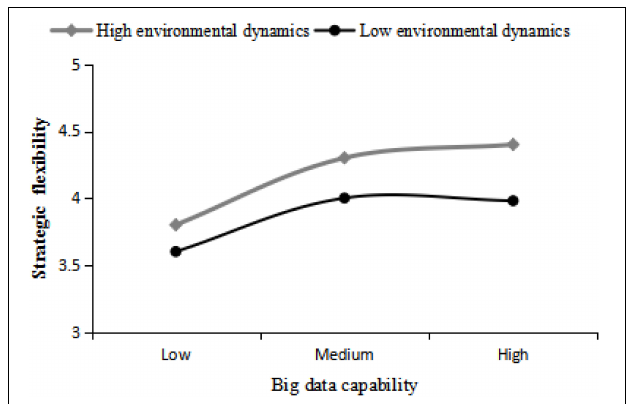
FIGURE 2 | Moderating effect of environmental